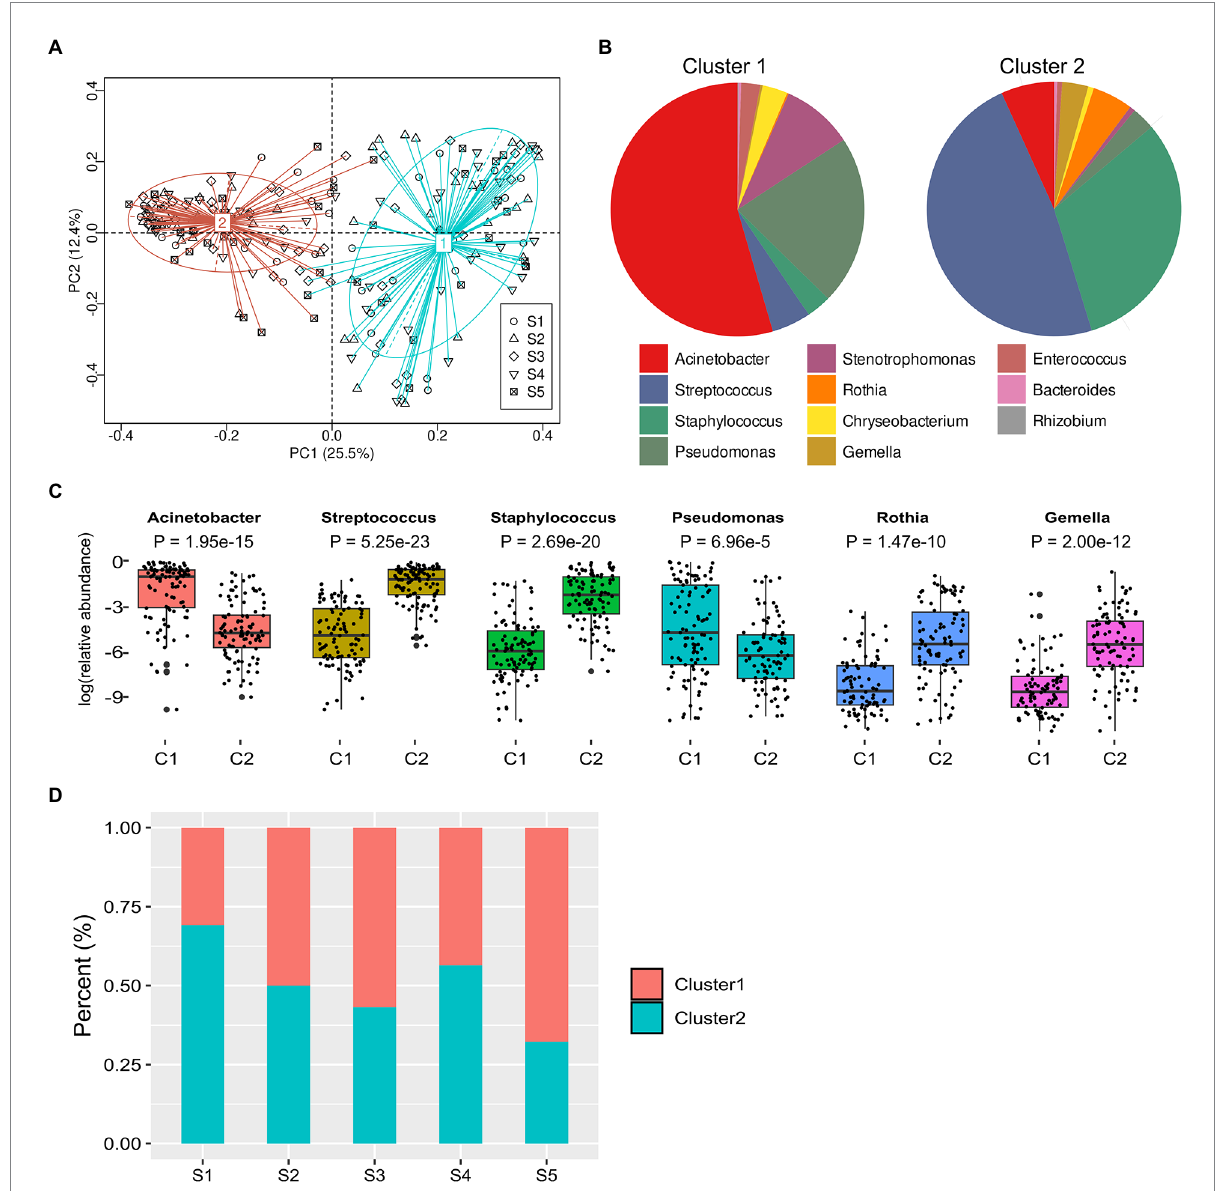
FIGURE 2 Partitioning around medoids (PAM) clustering and analysis of milk microbiome at different lactation phases. (A) , Principal Coordinate Analysis (PCoA) on the relative abundance data of clusters at different lactation phases. (B) , distribution of the top 15 predominant genera in two clusters. (C) , boxplot of the top 4 species from two clusters and MetaStat by permutation test [ p value was the adjusted result of Benjamini and Hochberg False Discovery Rate (BH FDR)]. * p < 0.05, ** p < 0.01. (D) , percentage of two clusters at lactation